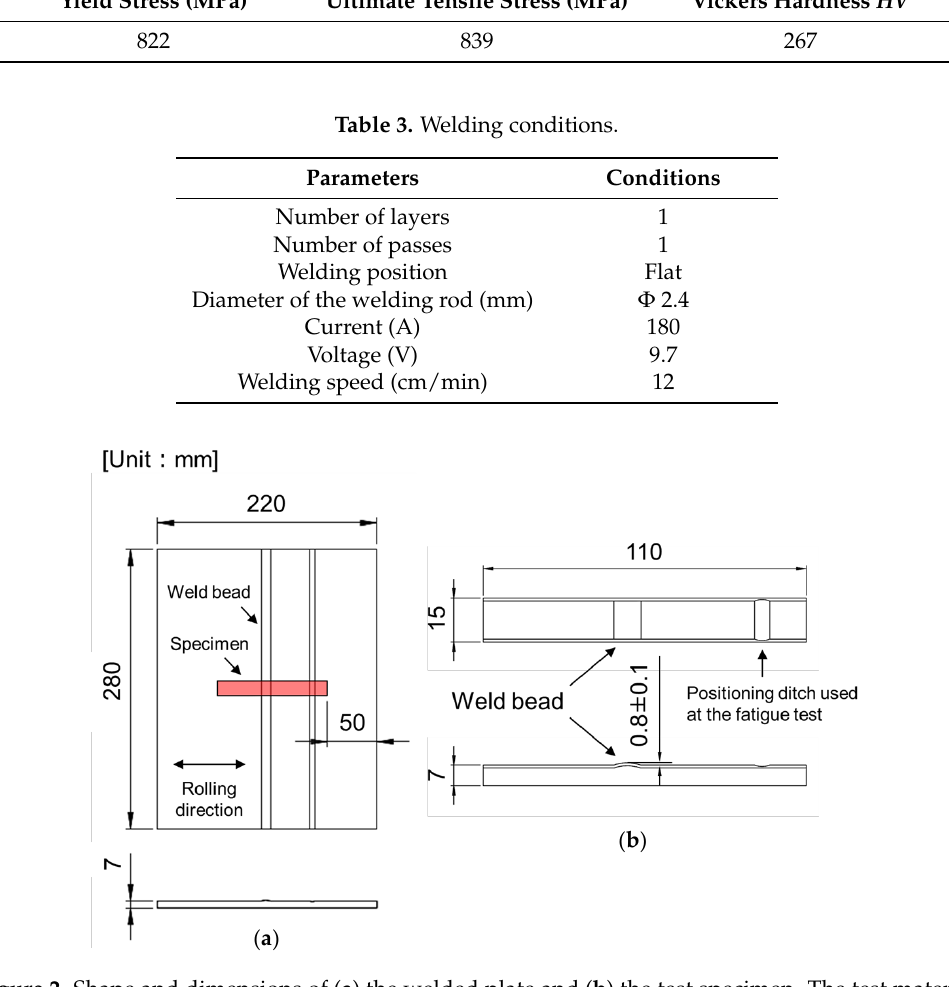
Figure 2. Shape and dimensions of ( a ) the welded plate and ( b ) the test specimen. The test material was supplied in the form of 7-mm-thick plates. The welded plate was cut to prepare the test specimens such that the longitudinal direction of the specimen corresponded to the rolling direction of the